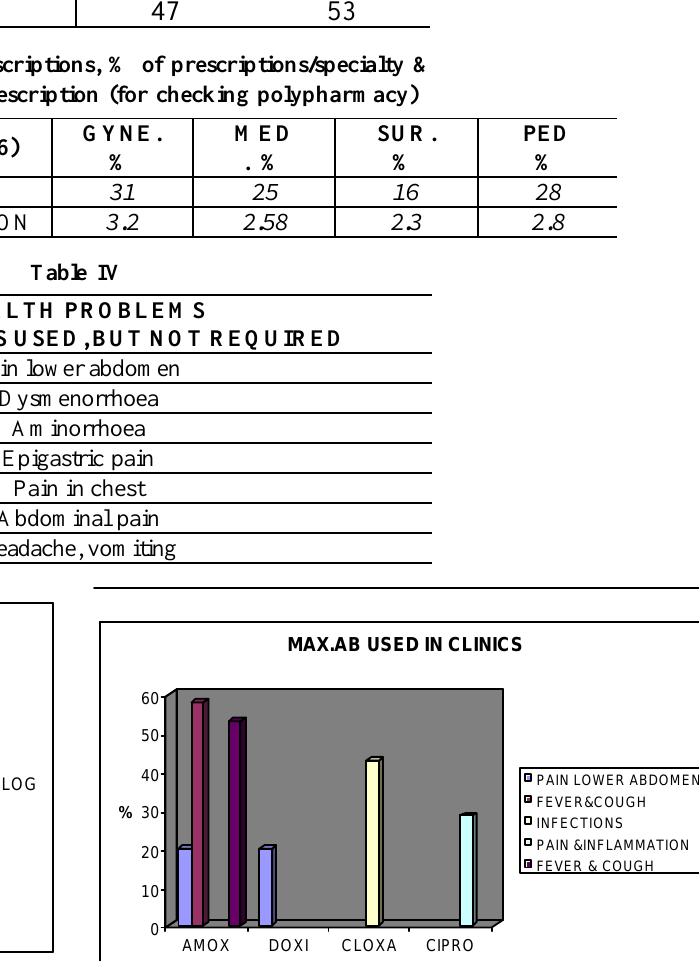
Fig. 1 : Use of AB. After proper investigations